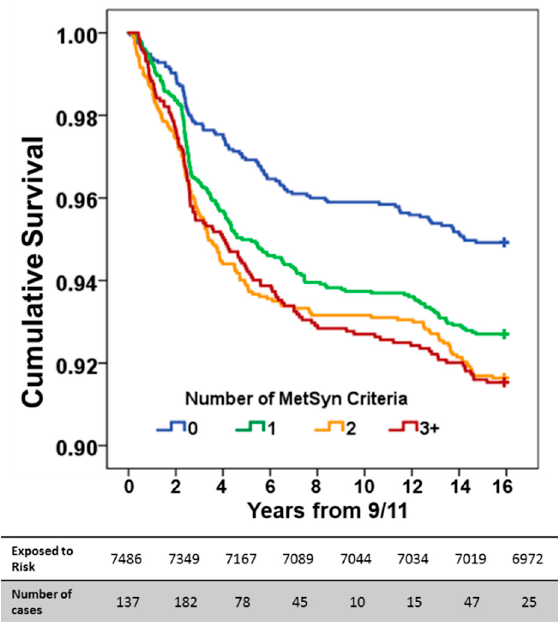
Figure 2. Cumulative AHR survival curves by total number of MetSyn biomarkers. Cumulative disease-free survival is expressed on the y -axis and time in years from their WTC exposure is on the x -axis. Life table expresses the number of individuals at risk in 2-year intervals.